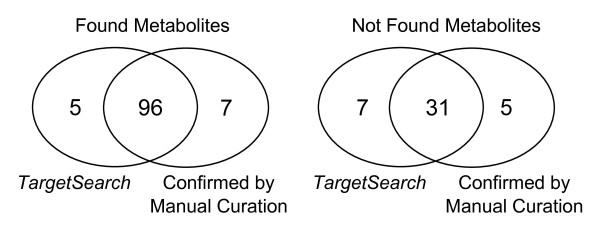
Comparison between identified metabolites by TargetSearch and manual curation. The venn diagrams show the number of metabolites considered to be either present or not present by TargetSearch in comparison to the manual curation. Left hand side: 96 metabolites identified by TargetSearch that were confirmed by manual curation. Right hand side: 31 metabolites not identified by TargetSearch and confirmed by manual curation. Both diagrams: 5 metabolites found by our software but not confirmed by manual curation, whilst 7 metabolites were not reported by TargetSearch but were present in the chromatograms.